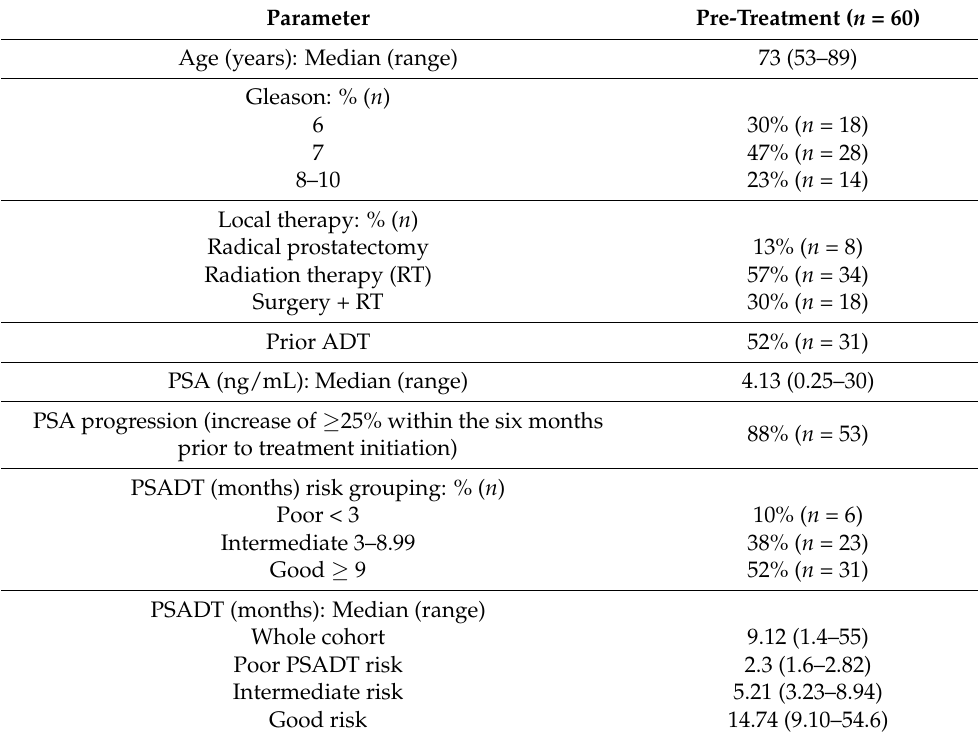
Table 1. Summary of the pre-treatment patient characteristics.